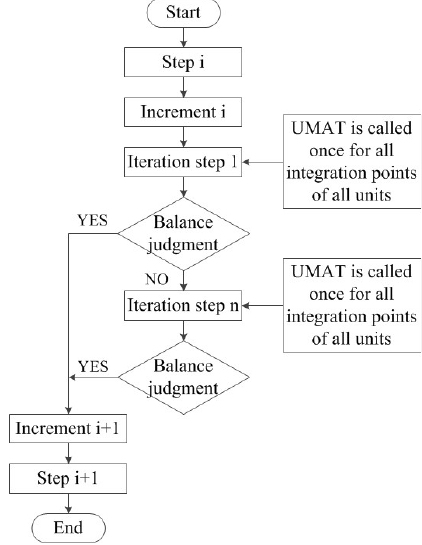
Figure 1. The internal operation flow chart of ABAQUS finite element software.